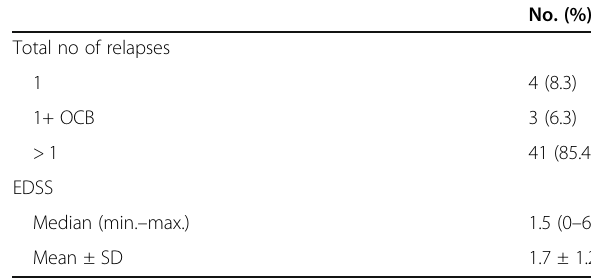
Table 2 Distribution of the studied cases according to number of relapses and EDSS at initial visit ( n =